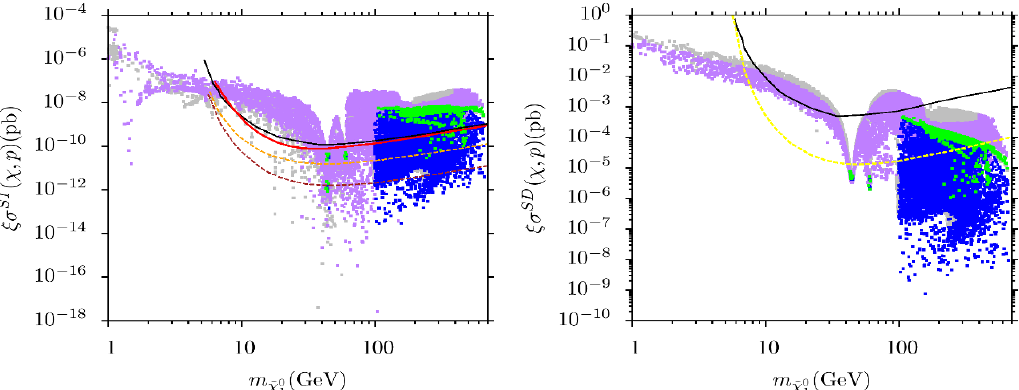
Figure 4 . Rescaled spin-independent (left) and spin-dependent (right) neutralino-proton scattering cross section vs. the neutralino mass. The scaling factor is de(cid:12)ned as (cid:24) (cid:17) (cid:10) (cid:31) h 2 = 0 : 12. The color code is the same as in (cid:12)gures 2 and 3. In the left plot, the solid black and red lines respectively represent the current LUX [95] and XENON1T [96] bounds, while the dashed orange and brown lines show the projection of future limits [97] of XENON1T with 2 t (cid:1) y exposure and XENONnT with 20 t (cid:1) y exposure, respectively. In the right plot, the black solid line is the current LUX bound [98] and the yellow dashed line represents the future LZ bound